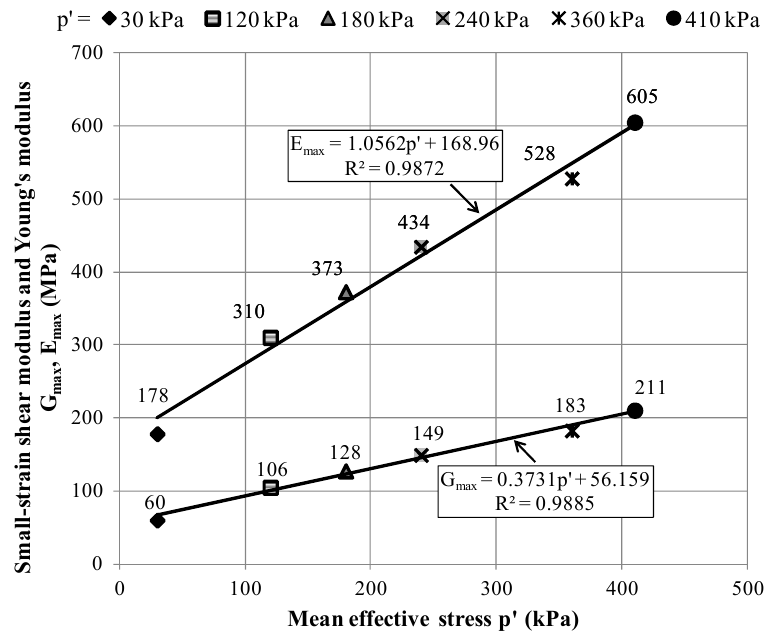
Figure 14. Elastic moduli from the peak-to-peak method under different stress levels.